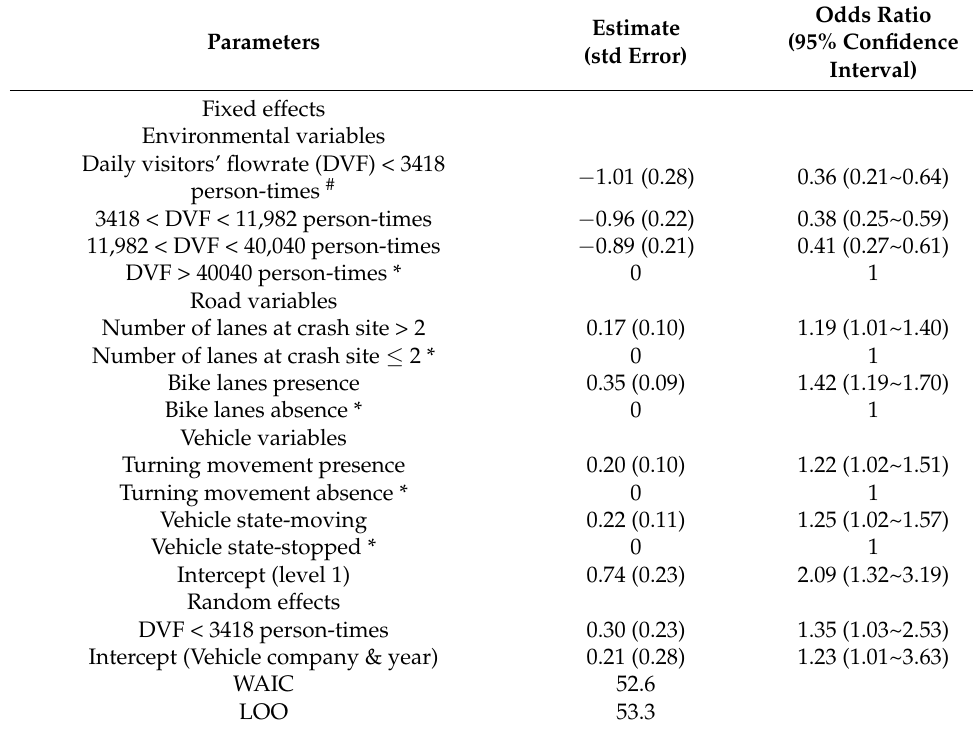
Table 4. The hierarchical Bayesian model for crash severity in the conventional